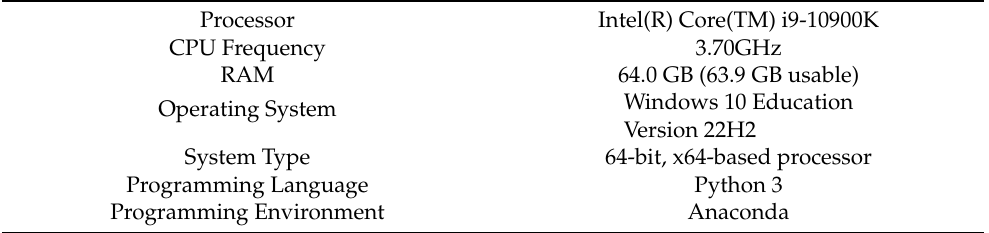
Table 3. Operating system